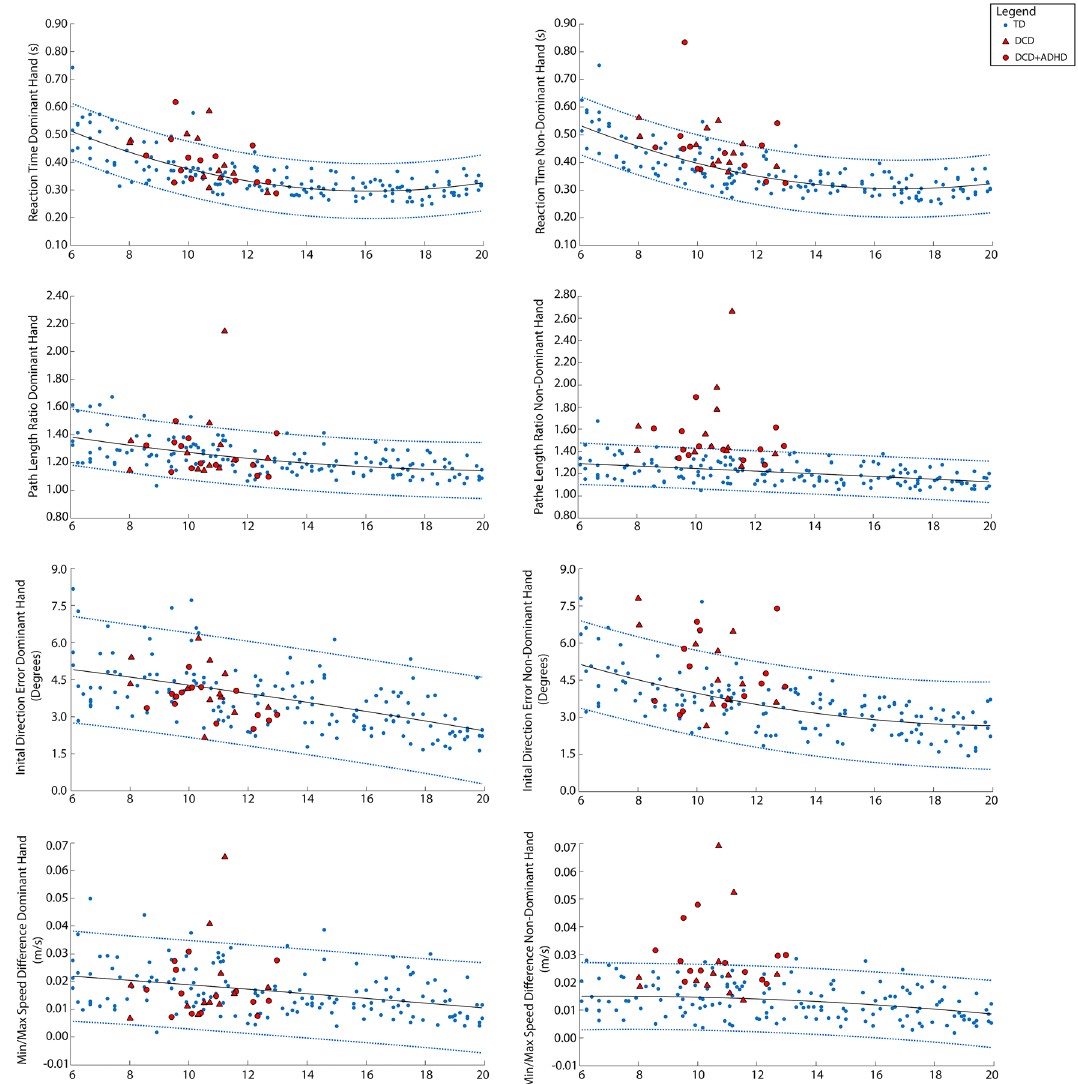
Figure 3. Individual performance of children with DCD on the visually guided reaching task. Age curves and 95% prediction bands based on performance of all TD participants (n = 155) are shown in blue. Performance scores of each DCD participant (n = 26) are superimposed and shown in red (triangles represent DCD participants without ADHD and circles represent DCD participants with co-occurring